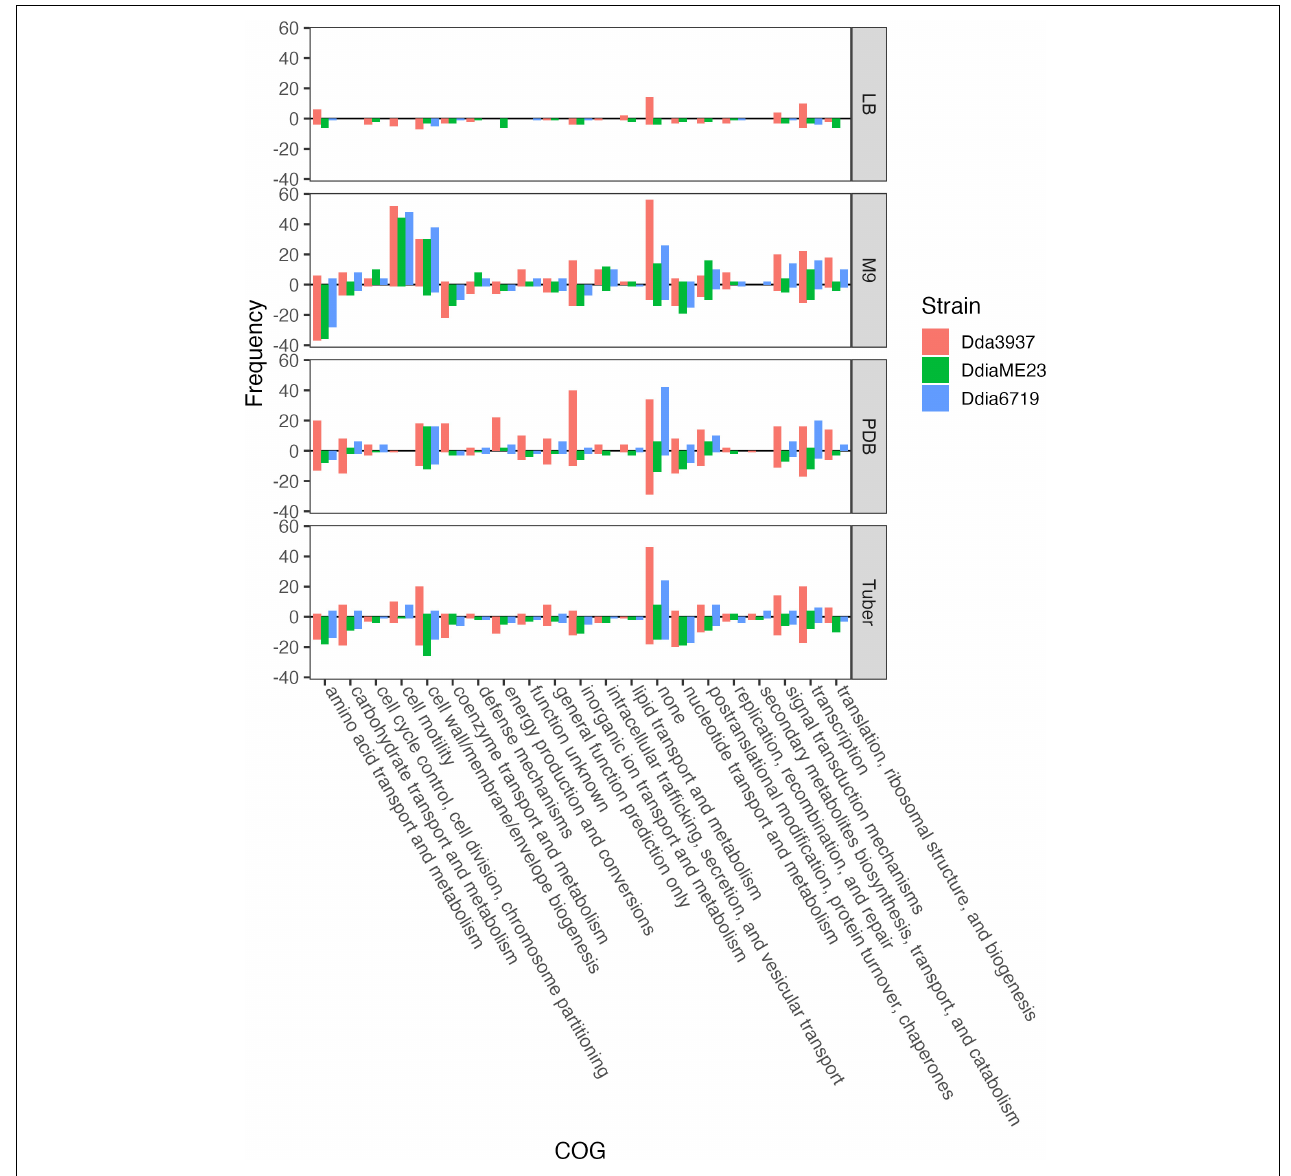
FIGURE 3 | Number of unique genes for each condition with fitness values of < –1 or > 1, and absolute t-like test statistic > 4 in at least one replicate sample. Genes where fit < –1 are show below the line y = 0, while genes where fit > 1 are shown above. COG assignments are based on the D. dadantii 3937 annotation in the IMG database (Chen et al., 2019), and extrapolated to D. dianthicola ME23 and D. dianthicola 67-19 based on PyParanoid-generated ortholog